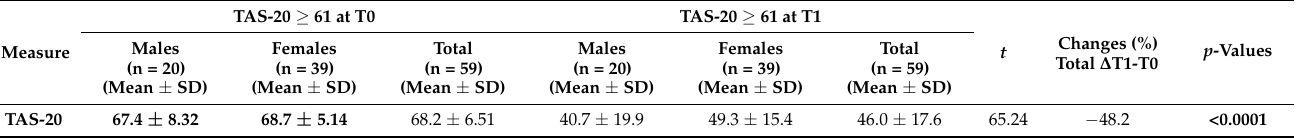
Table 3. Reduction of TAS-20 score after the intervention (T1) among students with TAS-20 ≥ 61 at baseline